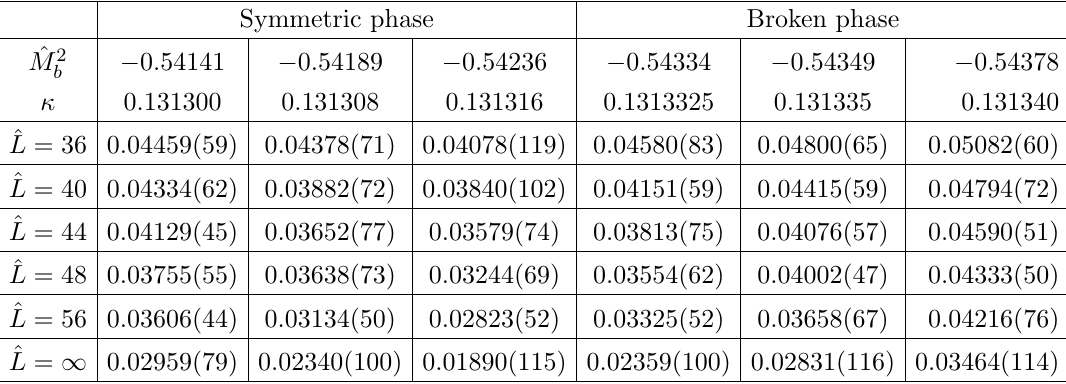
P , measured on our lattice, and its extrapolation